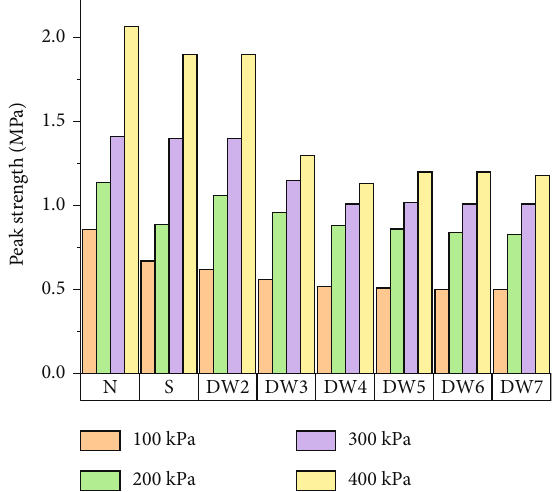
Figure 11: Strength under various drying – wetting cycle